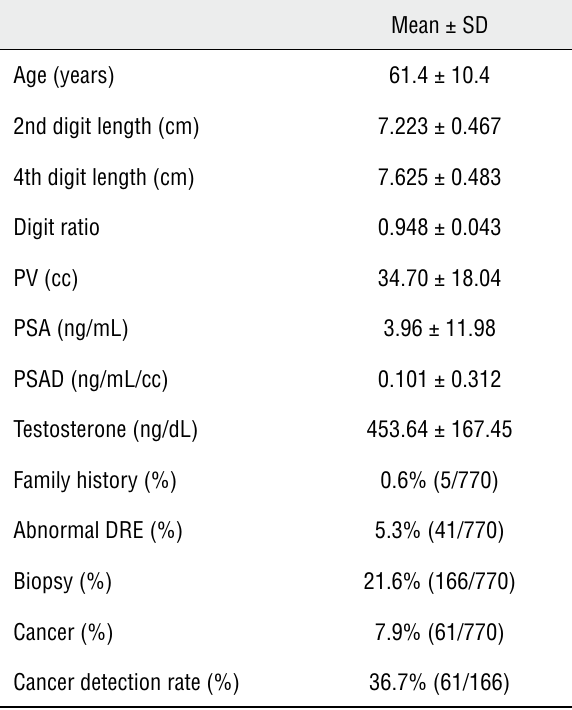
Table 1 - Characteristics of the studied